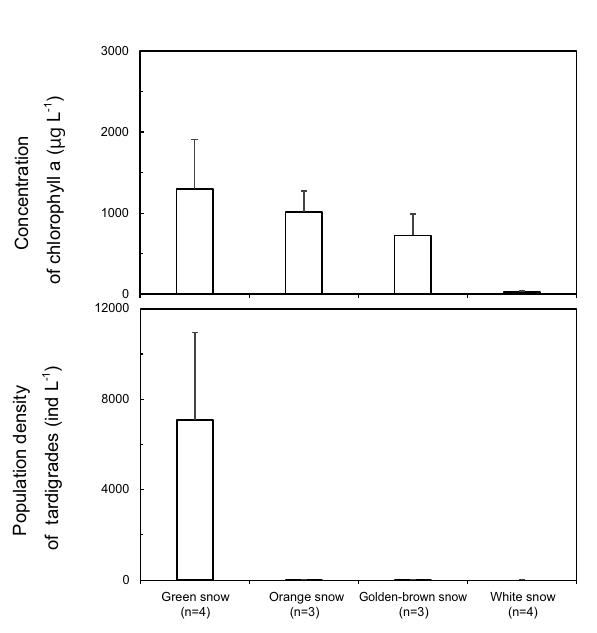
Figure 7. Population density of tardigrades and concentration of chlorophyll a per meltwater volume in each color type of snow collected in May, 2018. n: number of snow samples, error bar—standard